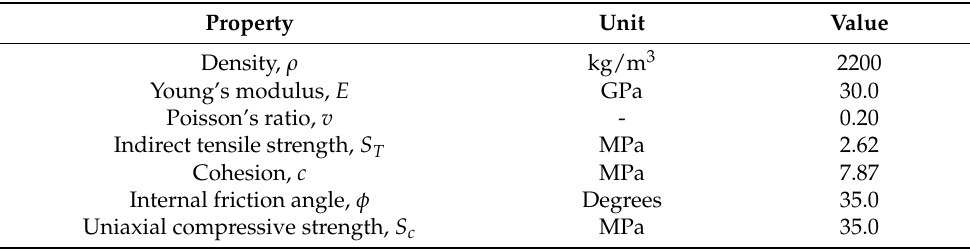
Table 1. Experimentally investigated physical and mechanical parameters of 35 MPa concrete in previous research [33].